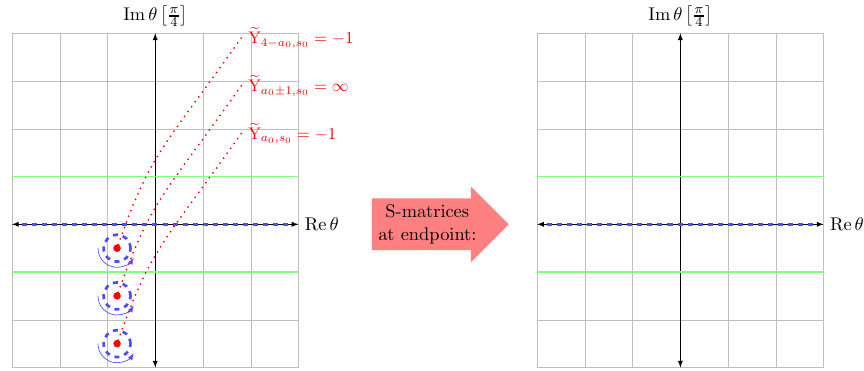
Figure 6 . Example of an analytic continuation in which all singularities of the diamond shown in figure 3 cross the integration contour indicated by the dashed blue line. The blue arrow indicates the orientation that the residue contributions of the crossing singularities are picked up with. The green solid line indicates the region − π . At the endpoint, the S-matrix contributions ≤ Im θ ≤ π 4 4 of the crossing singularities cancel and no S-matrices have to be taken into